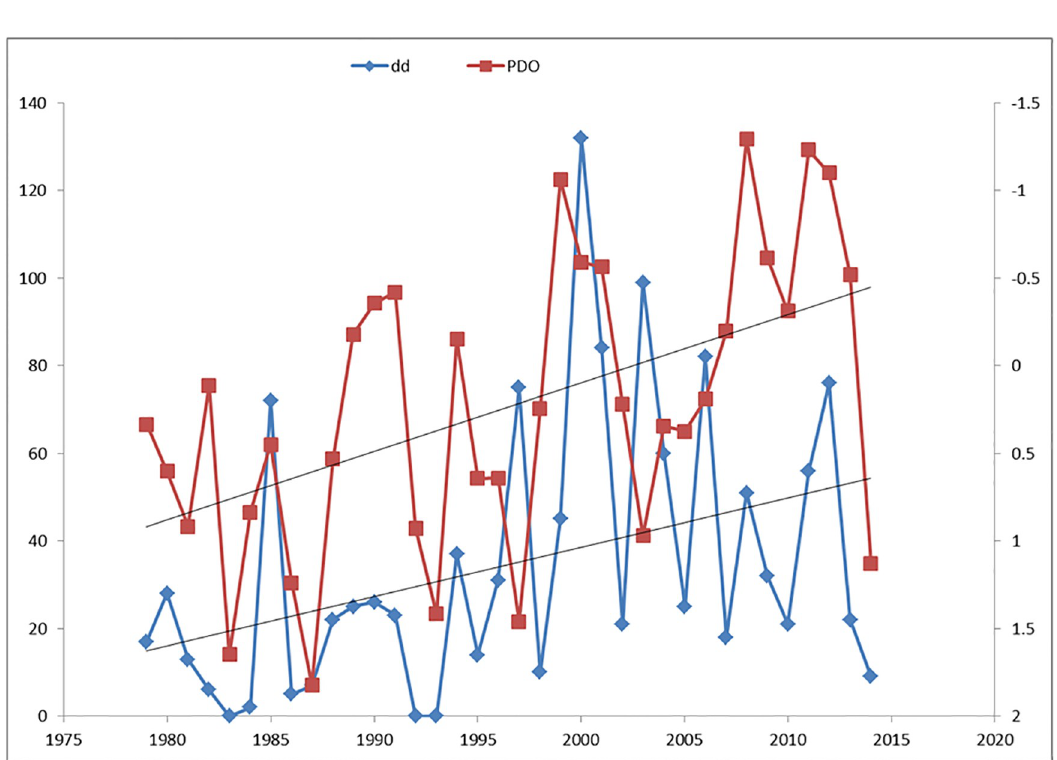
Fig 7. Trend of Pacific Decadal Oscillation (PDO) and days of discolorations (dd) from 1979 to 2014.